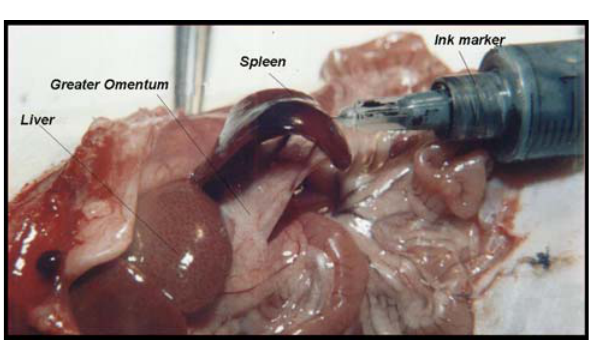
FIGURE 2 - Intrasplenic administration of the ink marker, 2x.